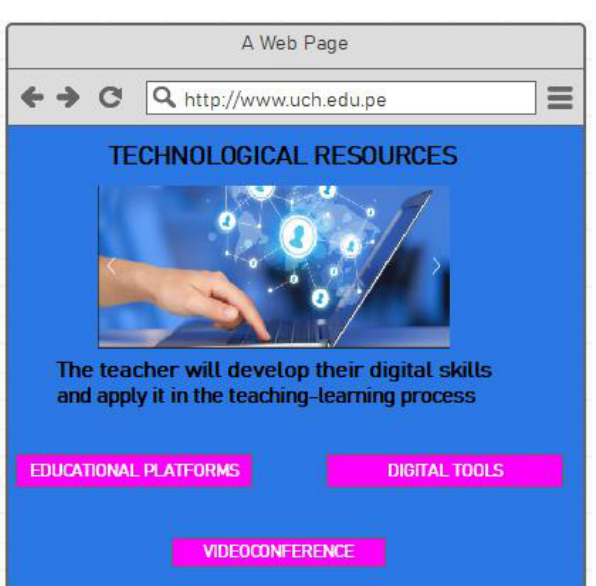
Fig. 10. Technological